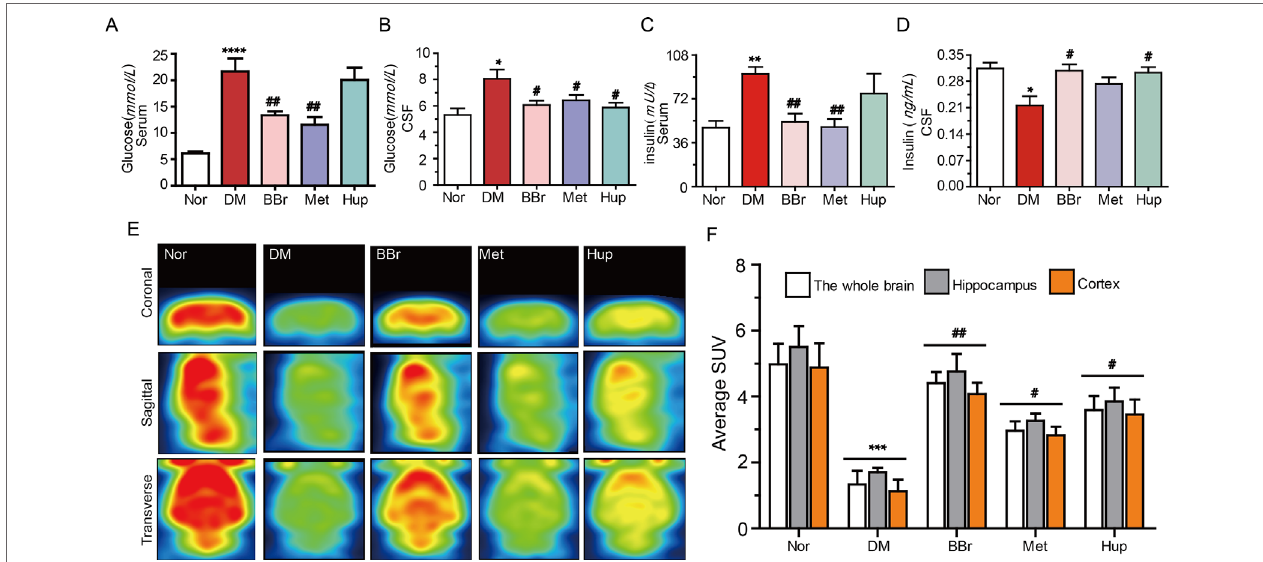
FIGURE 2 | Berberine improves glucose absorption and metabolism in diabetic rats. (A , B) Glucose levels in diabetic rat’s periphery and CSF, n = 8–12. (C , D) The insulin levels in diabetic rat’s periphery and CSF, n = 8–12. (E , F) The glucose metabolism in the brain were measured by PET imaging and quantified by fluorescence intensity, n = 3. * P < 0.05 vs. Nor; ** P < 0.01 vs. Nor; *** P < 0.001 vs. Nor; **** P < 0.0001 vs. Nor; # P < 0.05 vs. DM; ## P < 0.01 vs.